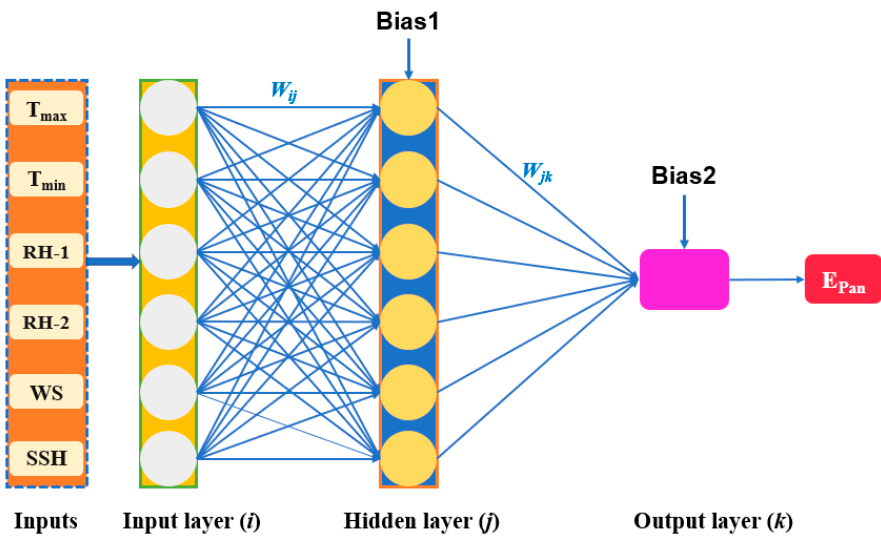
Figure 3. Three-layered structure of the artificial neural network.